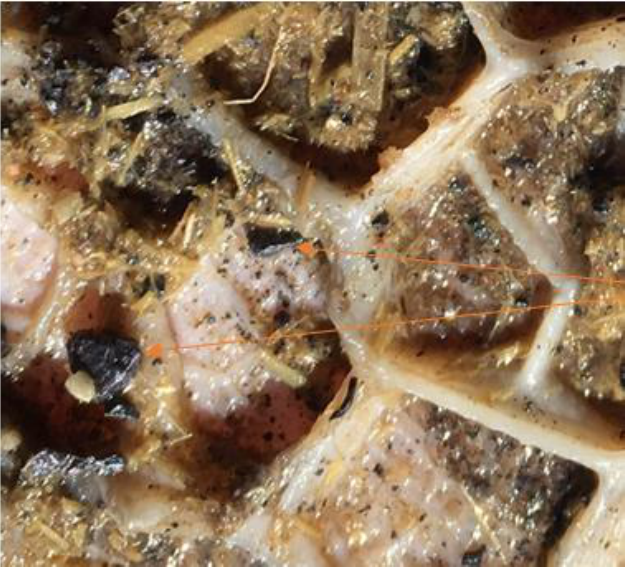
Figure 1. Pieces of lead (red arrows) trapped in mucosa of reticulum.